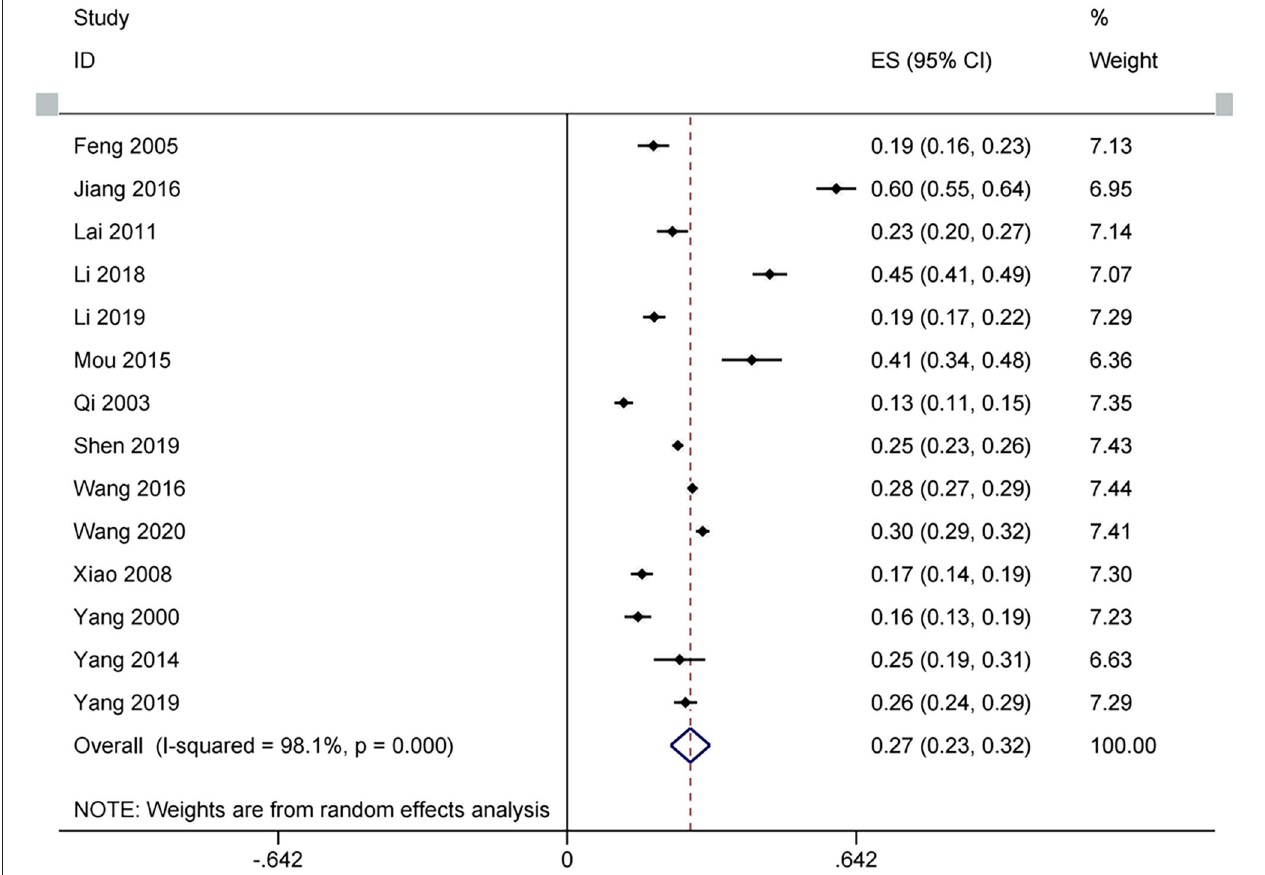
FIGURE 2 | Forest plots of sleep problems of Chinese medical students based on